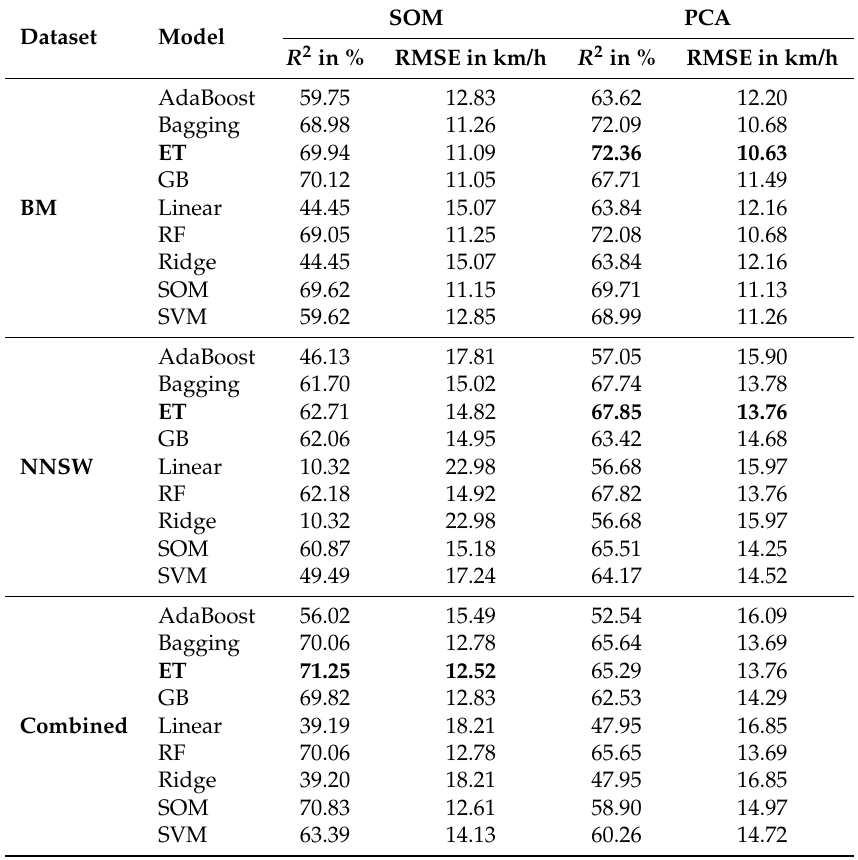
Table A3. Additional regression results for the average speed estimation on the BM dataset (Chile), the NNSW dataset (Australia), and the combined dataset. Input features for the ML models are the SOM features and the PCA